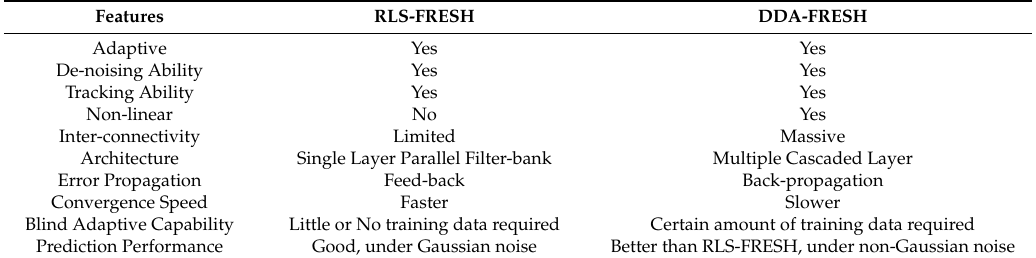
Table 1. Comparative Features between RLS-FRESH and